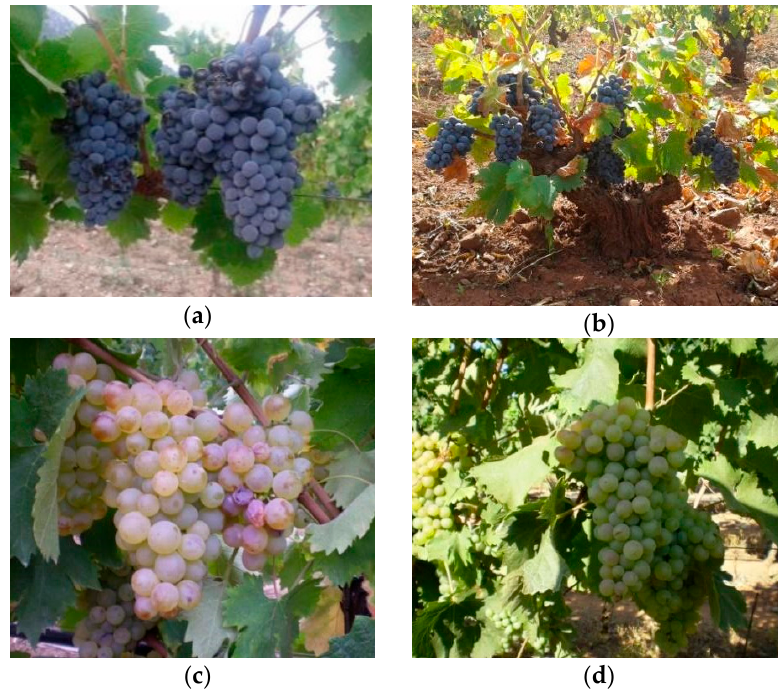
Figure 3. Samples images from GrapeCS-ML dataset 2: ( a – c ) include a color reference; ( d – f ) con- tain a volume reference.